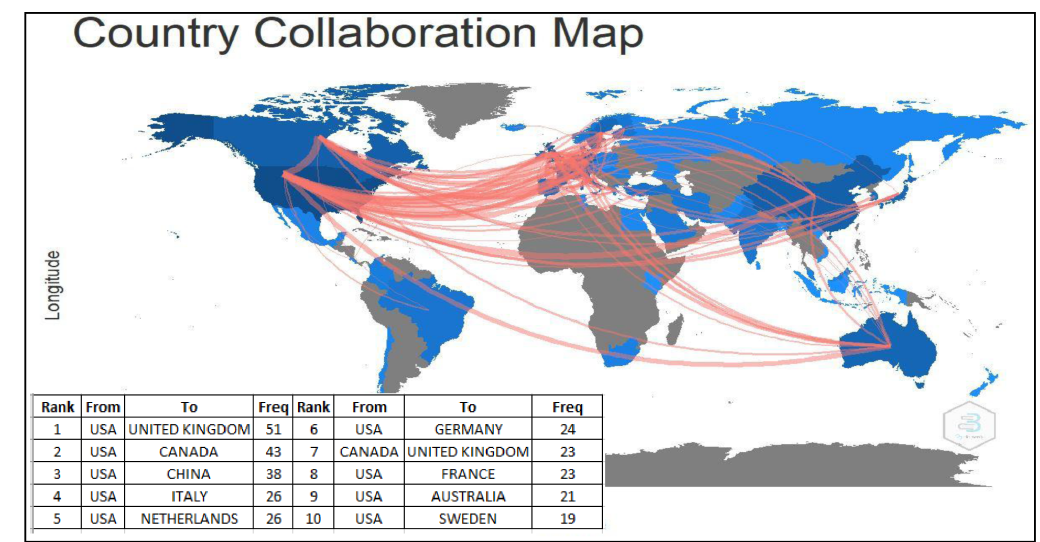
Figure 5. International collaboration